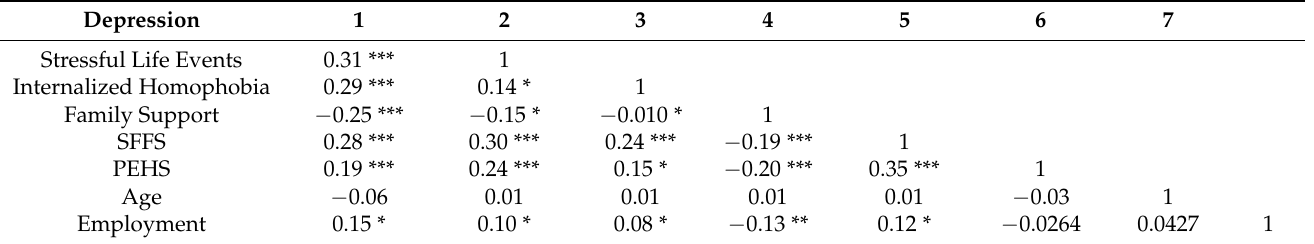
Table 2. Correlations on independent variables on depression.